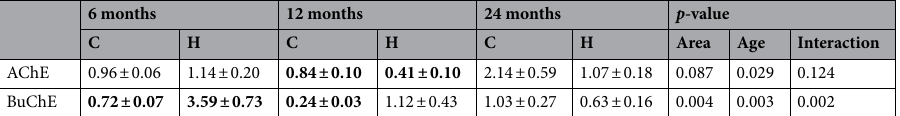
Table 4. Gene expression levels (2 –ΔΔCt ) of cholinesterase enzymes, in different brain regions and at different postnatal ages, in AD Tg mice in comparison to age-matched WT mice. Data are reported as mean ± SEM. p-values derived from a linear mixed model with brain region as the within variable and age as the between variable. Statistically significant comparisons with respect to WT mice are shown in bold characters (p < 0.05). C cortex, H hippocampus.